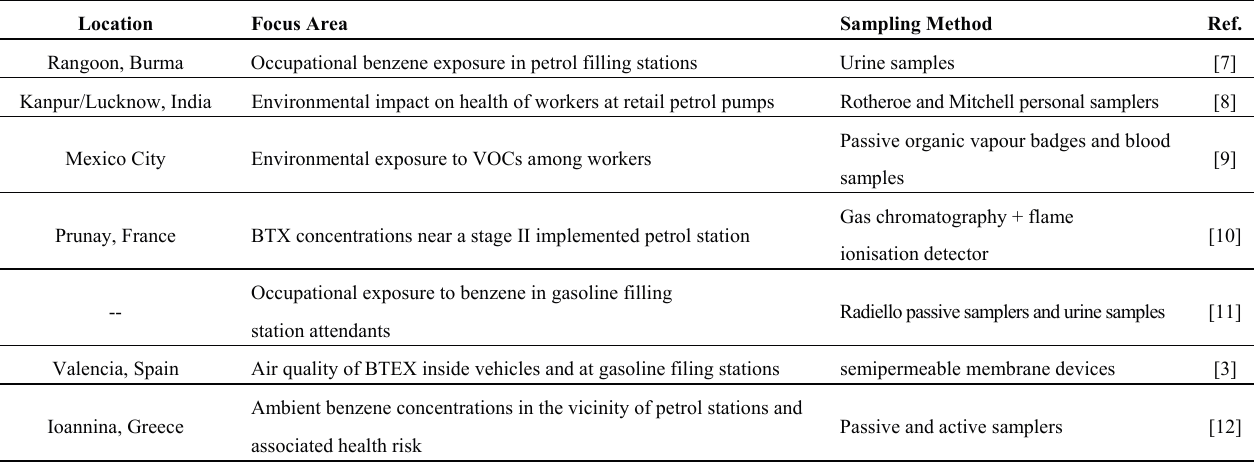
Table 1. A review of health risk assessments (HRAs), of various volatile organic compounds (VOC), specifically benzene, toluene, ethyl-benzene and xylenes (BTEX) studies, and conducted at/near petrol (gasoline) filling stations, in chronological date order. (BTX—Benzene, toluene and